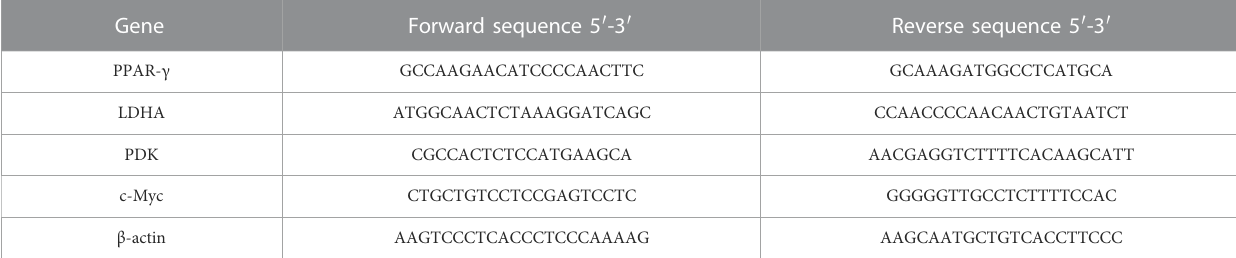
TABLE 1 | Primer sequences used in quantitative reverse transcription-polymerase chain